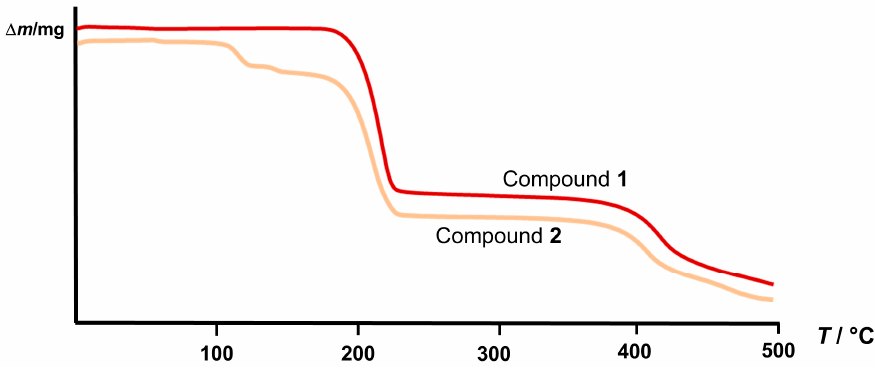
Figure 3. A comparison of the TG curves of 1 and 2 .